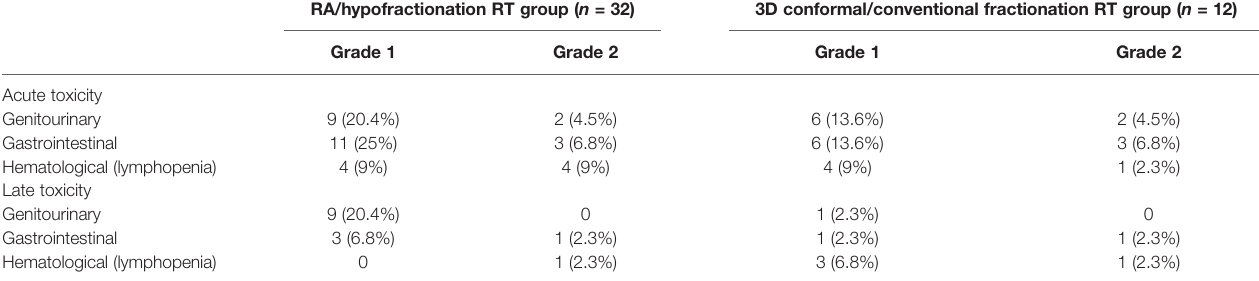
TABLE 3 | Toxicity